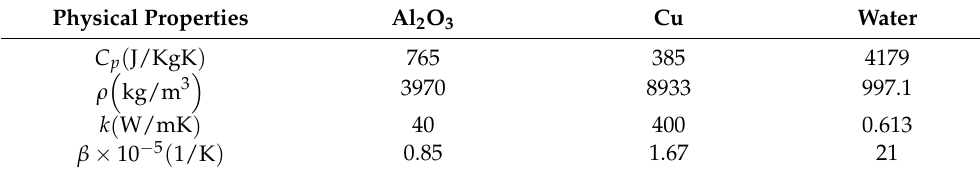
Table 2. Thermophysical properties of nanoparticles and water (base